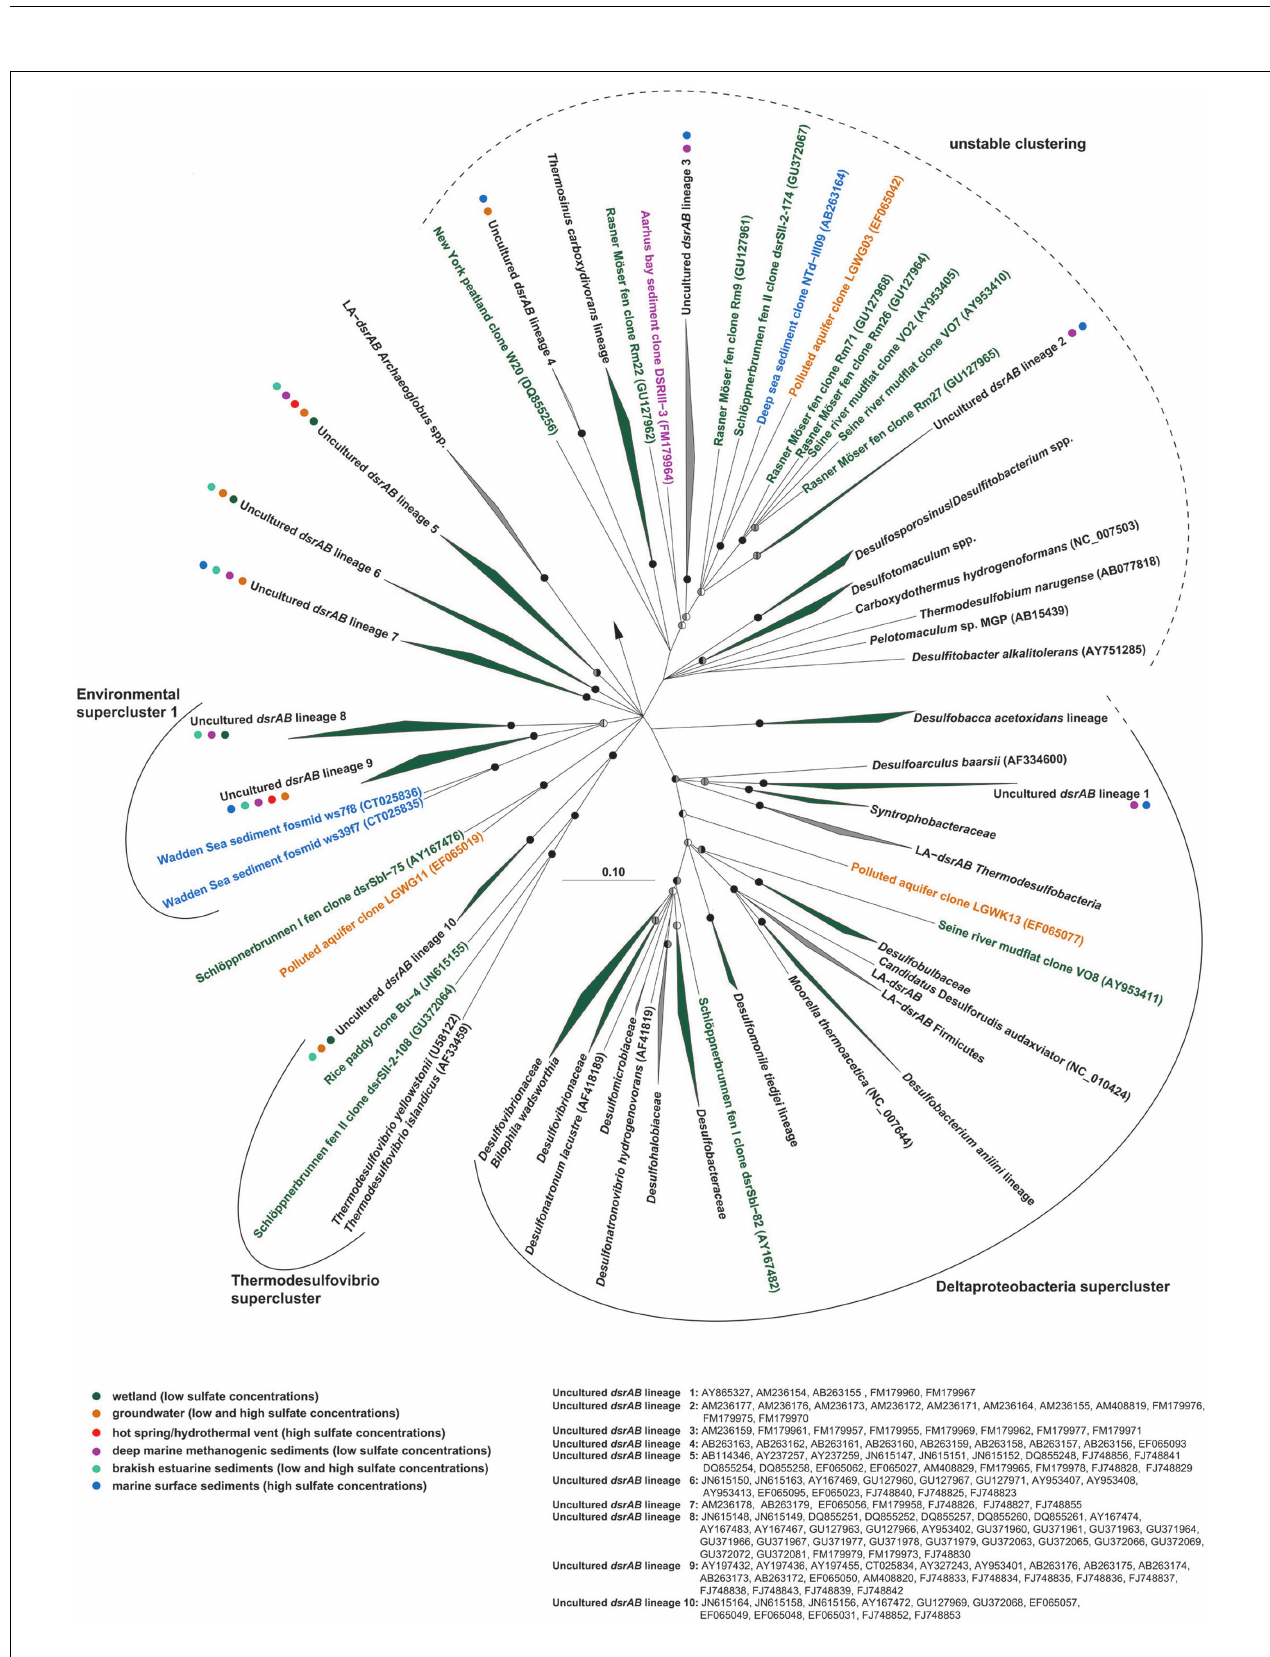
cultured microorganisms were grouped into an “uncultured dsrAB lineage” on the approximate family level if at least two sequences with ≥ 64%